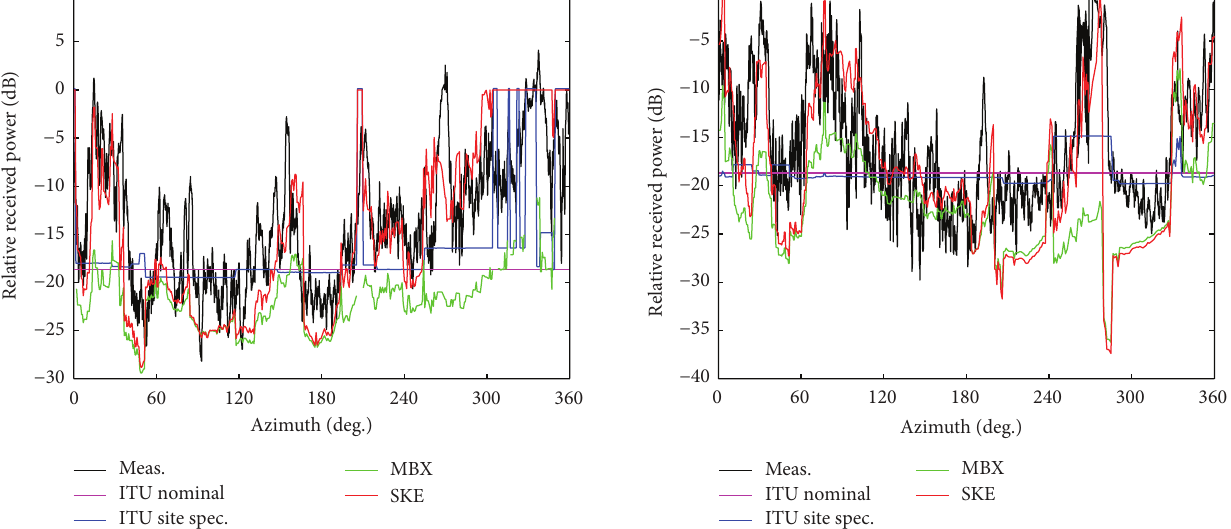
Figure 5: Scenario 1: a comparison of individual models: ITU-R P.452 nominal parameters (ITU nominal), ITU-R P.452 site-specific parameters (ITU site spec.), Maciel-Bertoni-Xia (MBX), single knife-edge (SKE), and measured data (meas.).